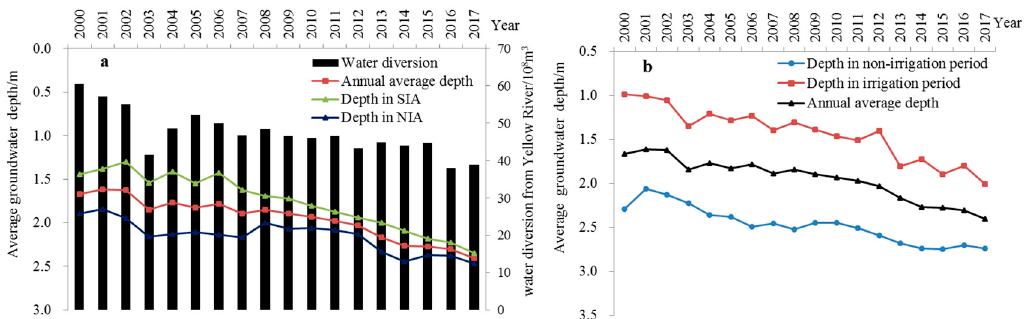
Figure 3. Annual average variation of groundwater depth during 2000–2017 in Yinchuan Oasis: ( a ) Groundwater depth variation between Southern and Northern Irrigation Areas, ( b ) Groundwater depth variation during irrigation and non-irrigation period.